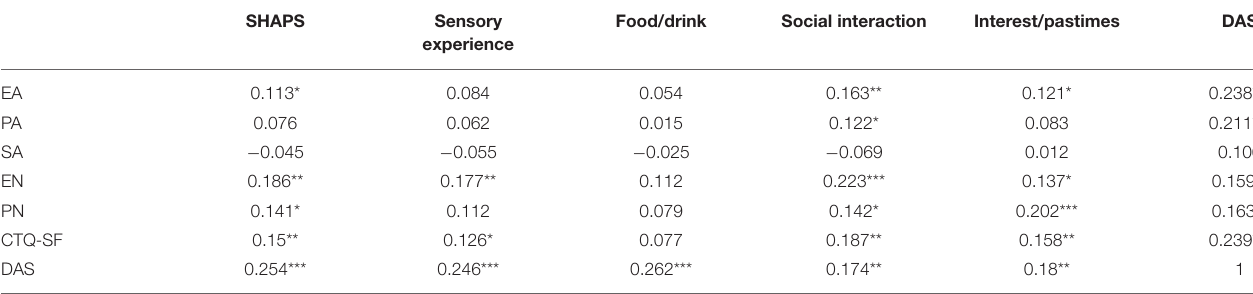
TABLE 3 | Spearman’s rank correlation between childhood traumas, anhedonia and dysfunctional attitudes. SHAPS